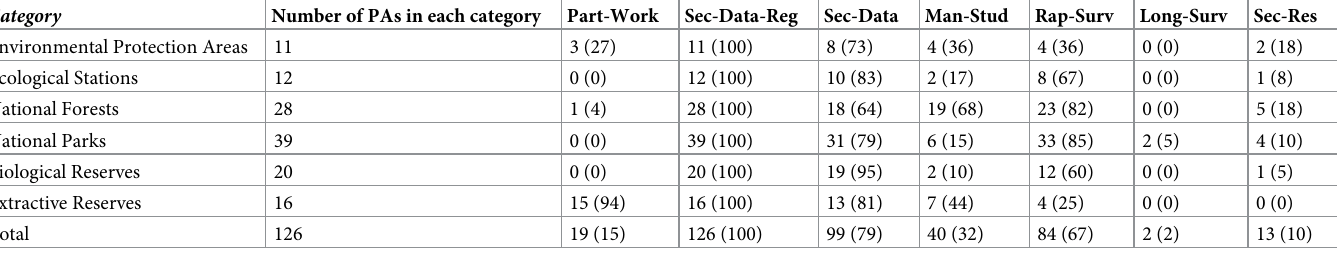
Table 1. Methods of obtaining data in diagnoses by each protected area category. Figures are the number of times each method was used and their respective percent- ages (in parentheses). Category